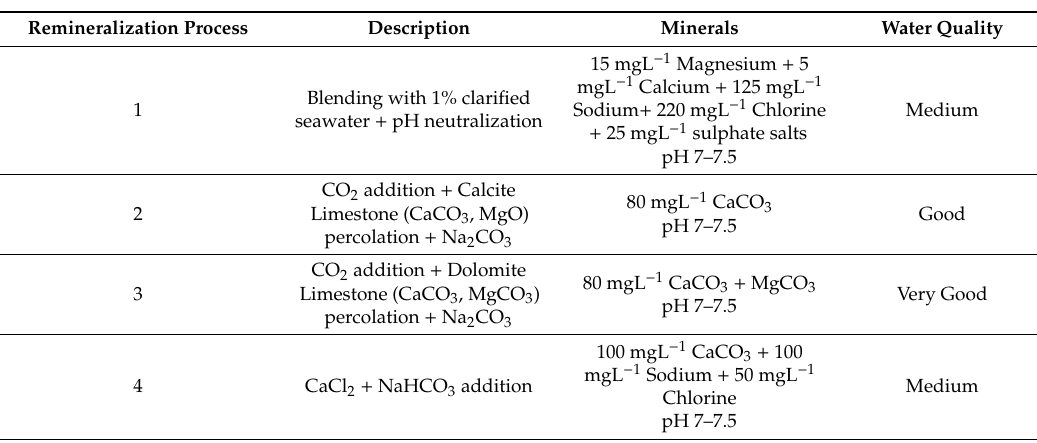
Table 4. Post-treatment process details [19] [Copyright © 1998–2019 Lenntech B.V. All rights